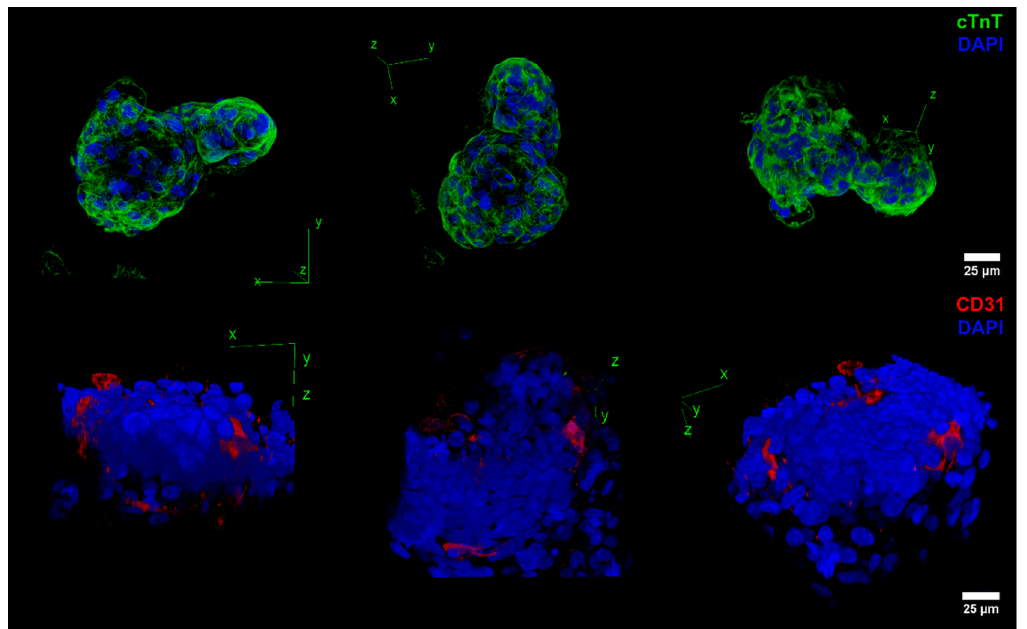
Figure 4. Confocal fluorescence microscopy of aggregates supplemented with VEGF showed the presence of microvessel-like structures. Representative 3D projection of aggregates supplemented with VEGF stained with cTnT and DAPI or CD31 and DAPI. Supplementation of VEGF maintained tissue complexity and cTnT expression, while resulting in the development of CD31-positive microvessel-like structures. Scale bar: 25 µm.